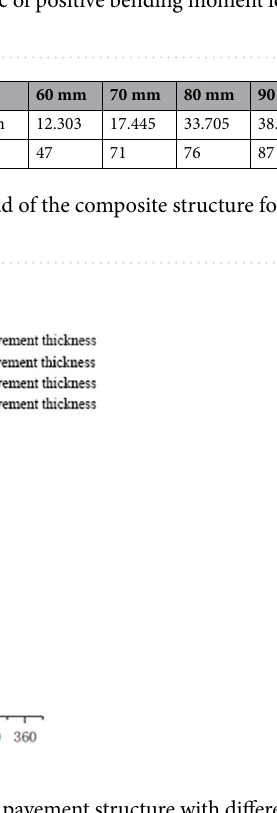
Figure 5. Load–displacement curve of a single-layer pavement structure with different pavement thicknesses in the linear elastic stage under the simulated action of a positive bending